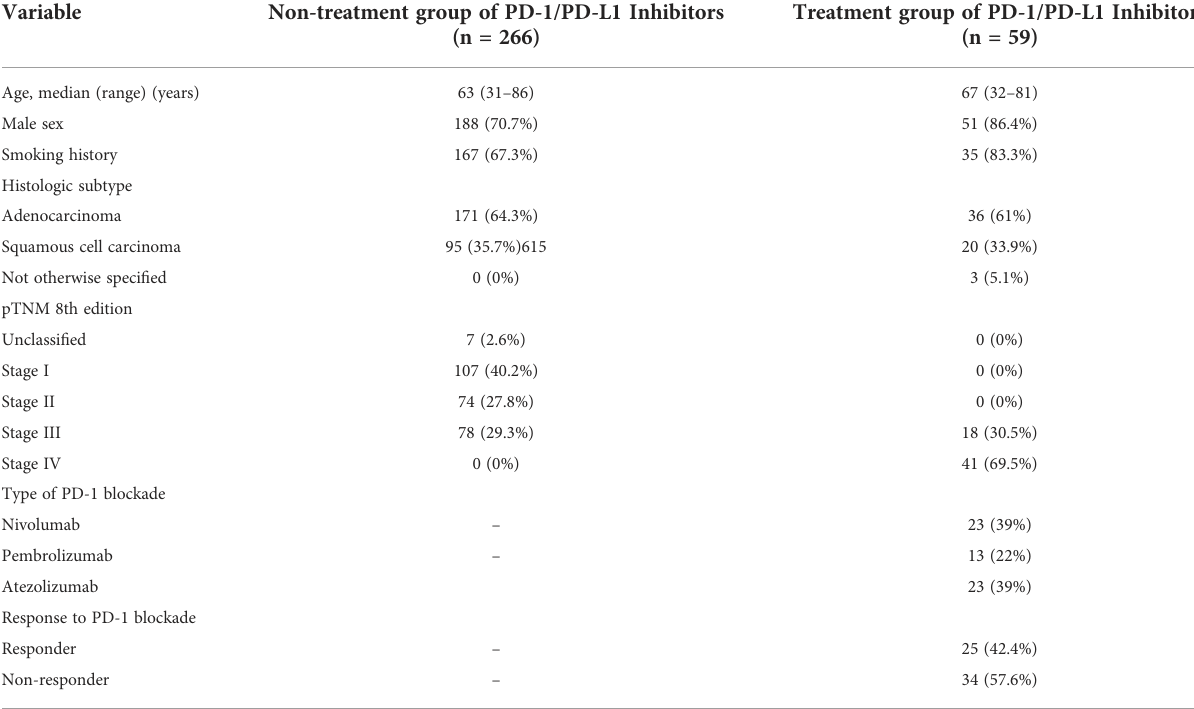
TABLE 1 Demographic and clinical characteristics of